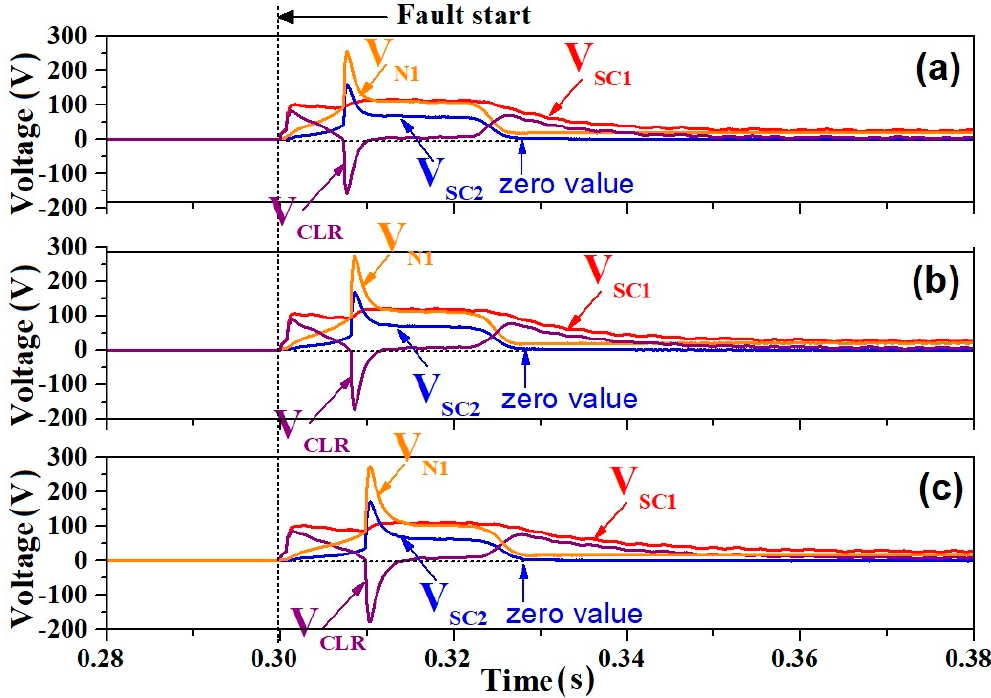
Figure 8. Voltage waveforms due to the CLR’s inductance: ( a ) L S = 6.6 mH; ( b ) L S = 7.5 mH; ( c ) L S = 10 mH.